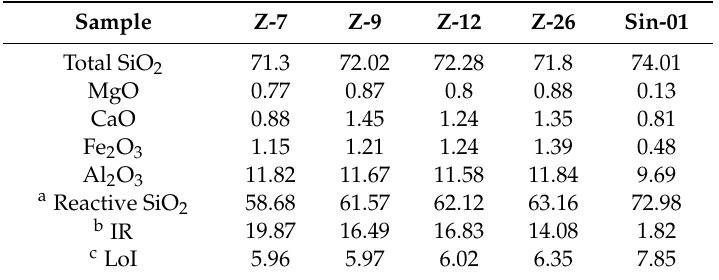
Table 3. Results of chemical analysis of the mixtures of mordenite and cement.